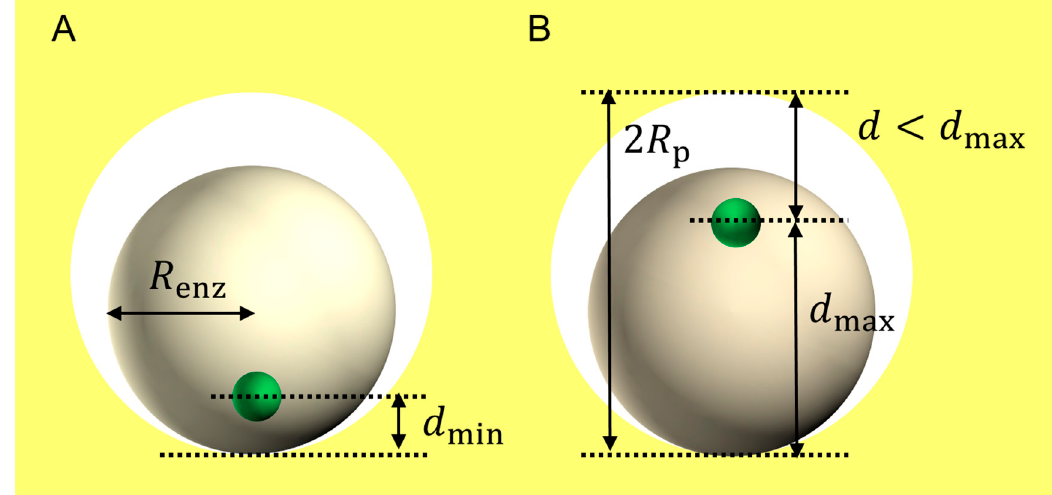
Figure 3. Schematic model of an adsorbed spherical enzyme with a radius of R enz in a micropore with a radius of R p on electrodes. ( A ) and ( B ) show the closest and farthest approaches of the redox center (small spheres), respectively.